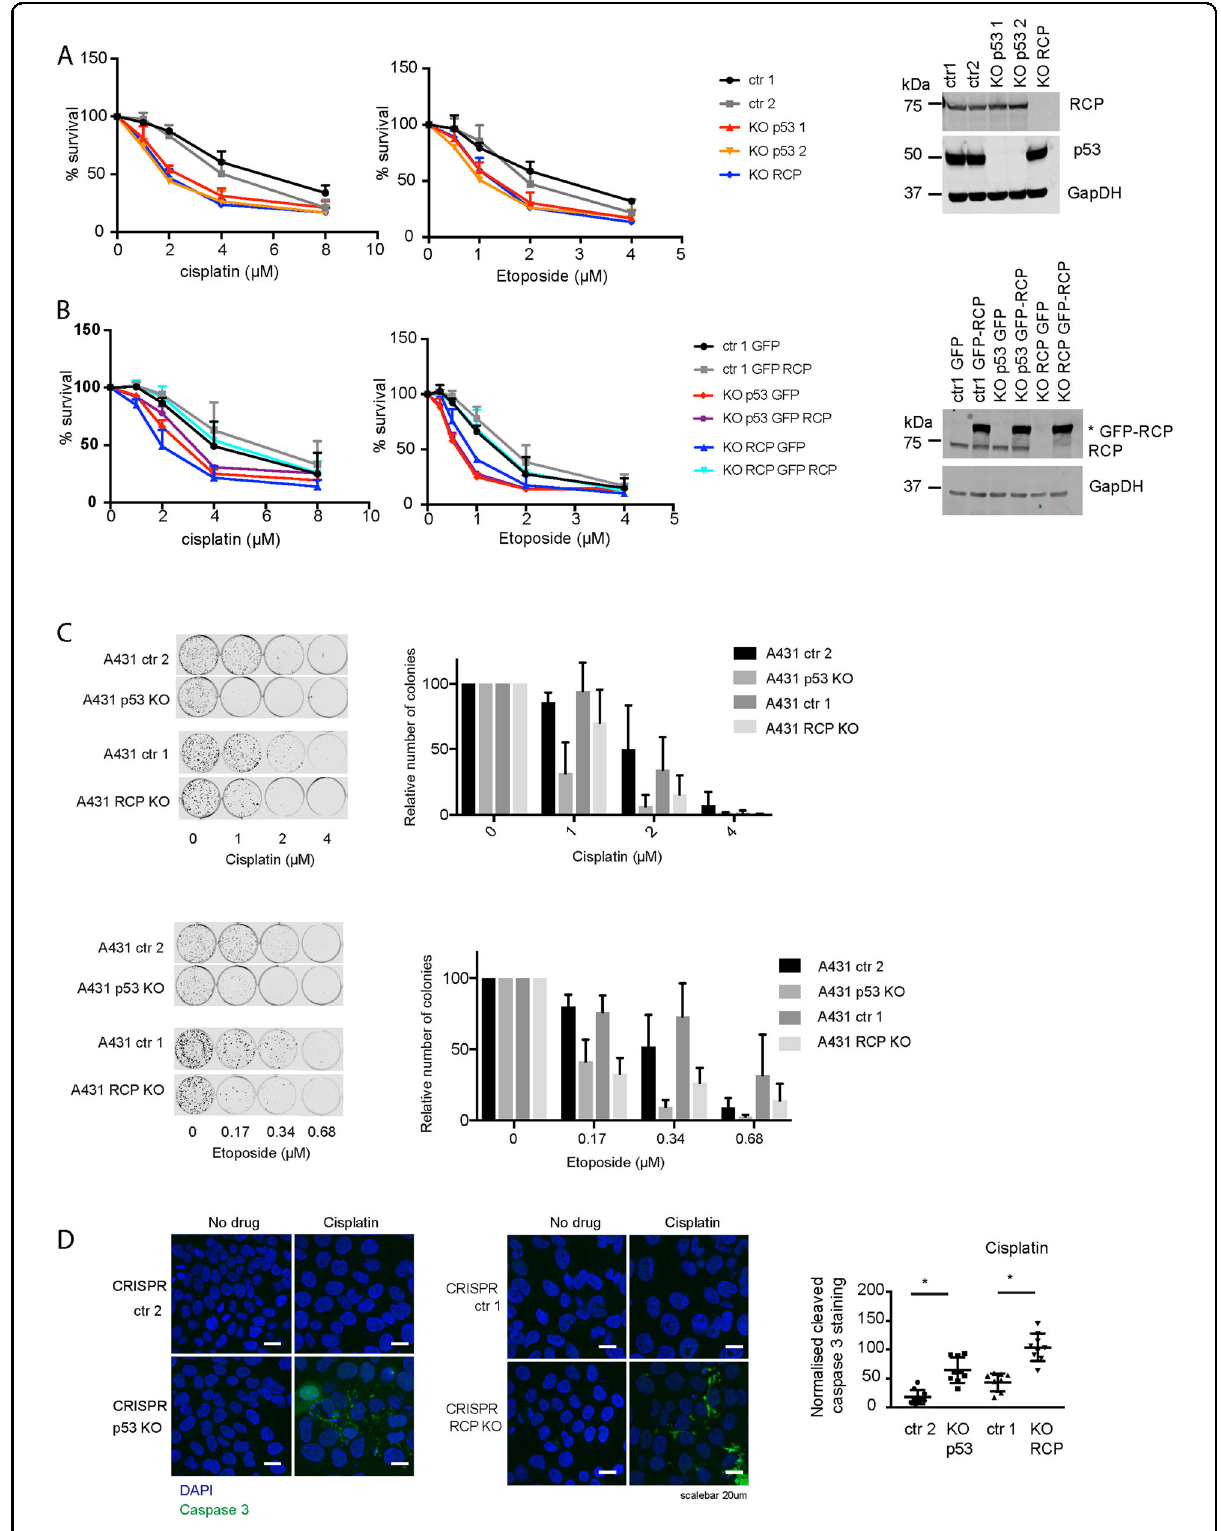
Fig. 1 (See legend on next